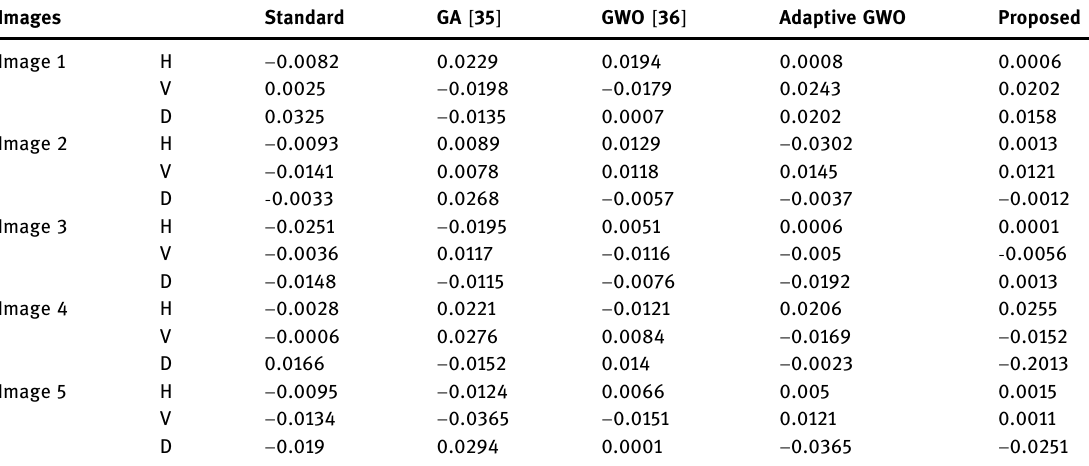
Table 2: Autocorrelation of adjacent pixels using three ultrasound images